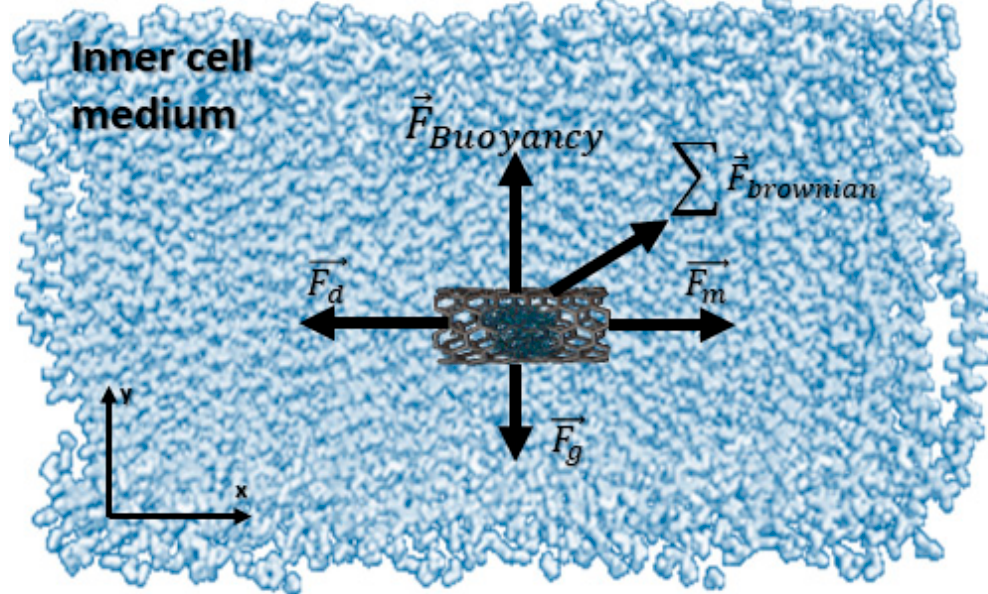
Figure 7. Free diagram of forces flowing inside the cell. In this diagram, the drag force is created by flow and the actuation force is applied by the external magnetic field device. Buoyancy forces and Brownian forces are shown in the figure. The total forces regarding the gravity and buoyancy are neglectable. Brownian forces create random motion, which depends on the medium temperature.